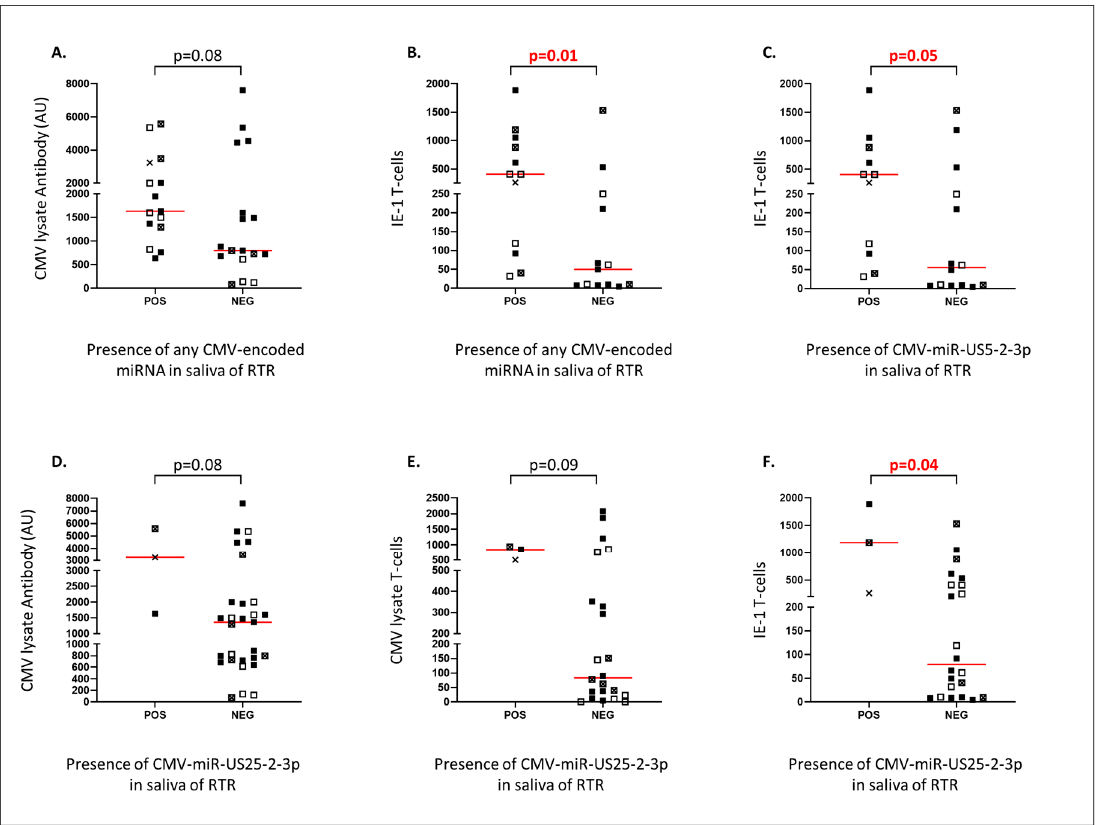
Figure 2. Human cytomegalovirus (HCMV)-encoded microRNAs (miRNAs) were detected using pre-designed assays. Plots ( A , B ) compare the levels of HCMV lysate reactive antibodies and IE-1 specific T-cells with the presence of any miRNA assessed. Plot ( C ) compares the levels of IE-1 specific T-cells with the presence of HCMV-miR-US5-2-3p. Plots ( D – F ), compare levels of HCMV lysate reactive antibodies and T-cells reactive with HCMV lysate or IE-1 with the presence of HCMV-miR-US25-2-3p. POS: miRNA detected. NEG: miRNA not detected. p -values are based on Mann–Whitney tests. ■ : HCMV DNA negative, >638 AU of HCMV reactive antibodies. □ : HCMV DNA positive in plasma (Abbot assay). ×: HCMV DNA positive in saliva (UL54). : HCMV DNA positive in plasma and saliva.